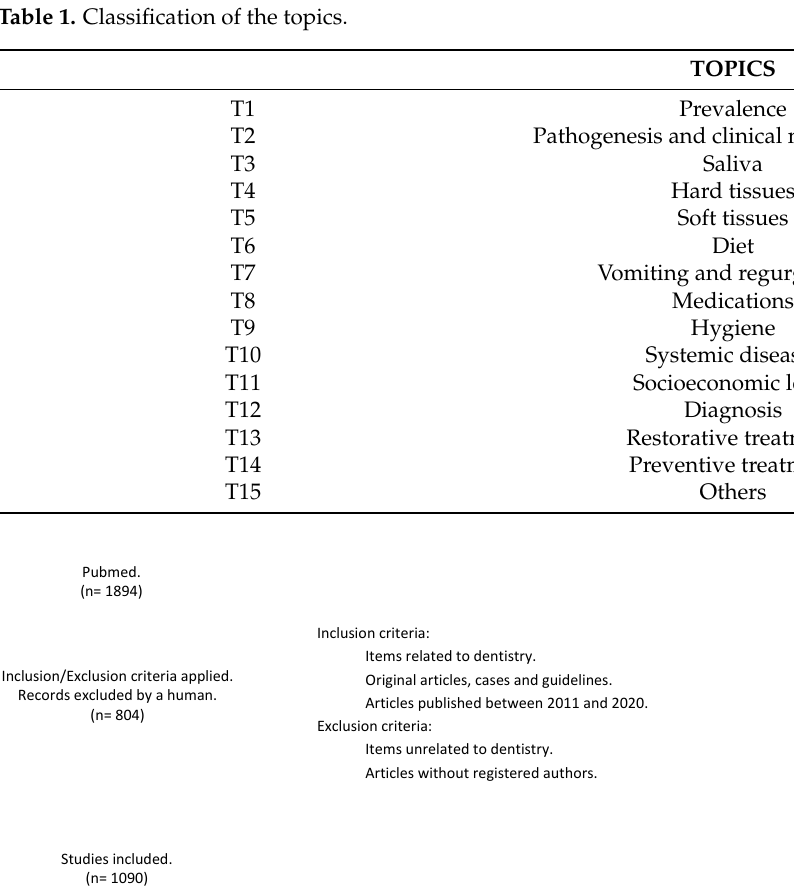
Table 1. Classification of the topics.